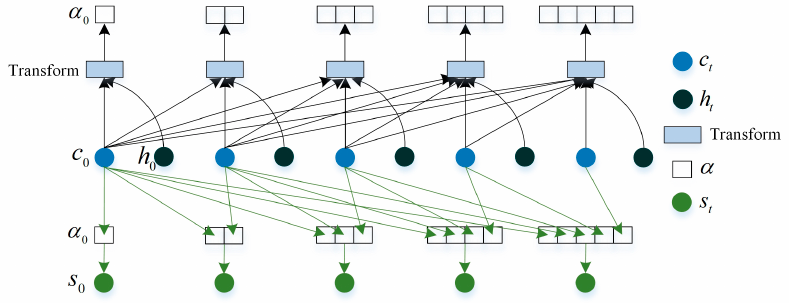
Figure 4. The architecture of attention2. This structure can learn a set of weights, which represent the degree of attention to different words that have been generated. At each time t , attention2 uses the previously predicted word information.